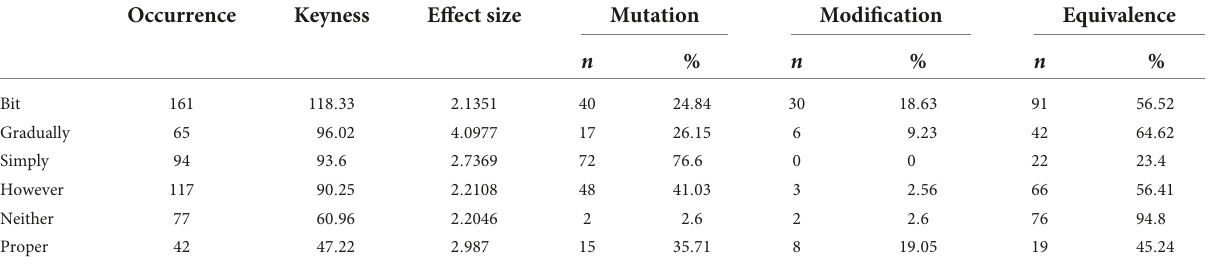
TABLE 3 Translation strategies for the TT